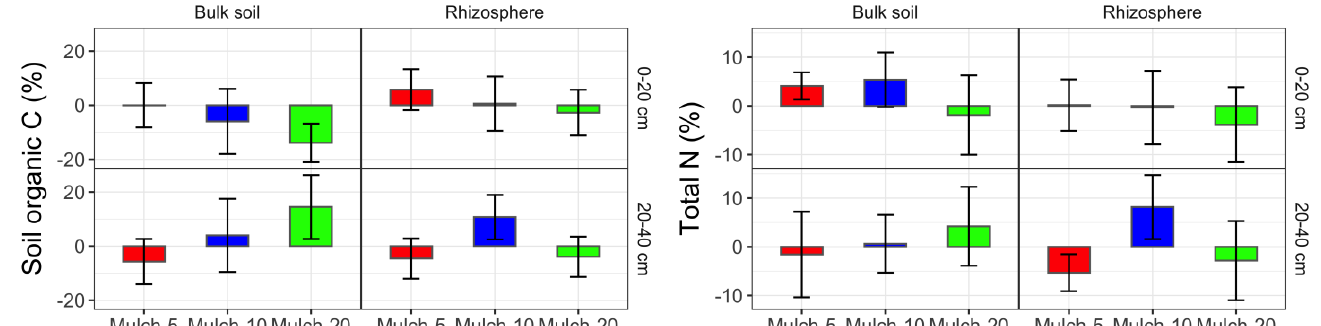
Figure 2. Differences in enzyme activities between the rhizosphere and bulk soil based on organic mulching. Values represent mean ± standard error ( n = 5). Values above the 0 line indicate higher enzymatic activity in the rhizosphere than in the bulk soil. Treatments: Mulch-5, Mulch-10, and Mulch-20, corresponding to organic mulching to a depth of 5, 10 and 20 cm, respectively.